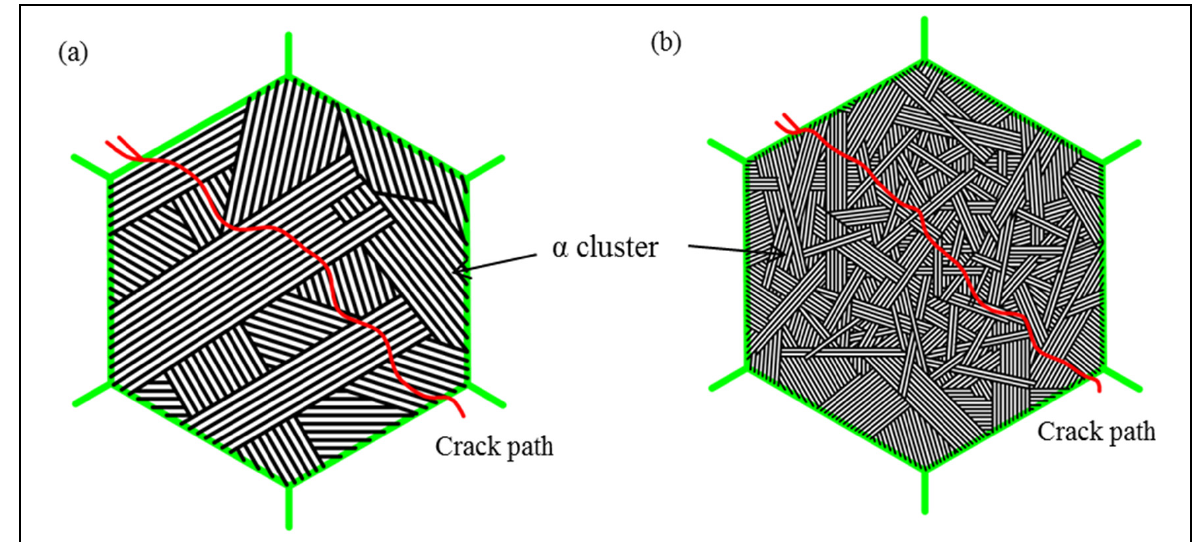
Figure 12. Schematic diagrams of cracks propagation mechanism in FC and OFC (white: α phase, black: β phase, and green: GB). ( a ) FC specimen, ( b ) OFC specimen.